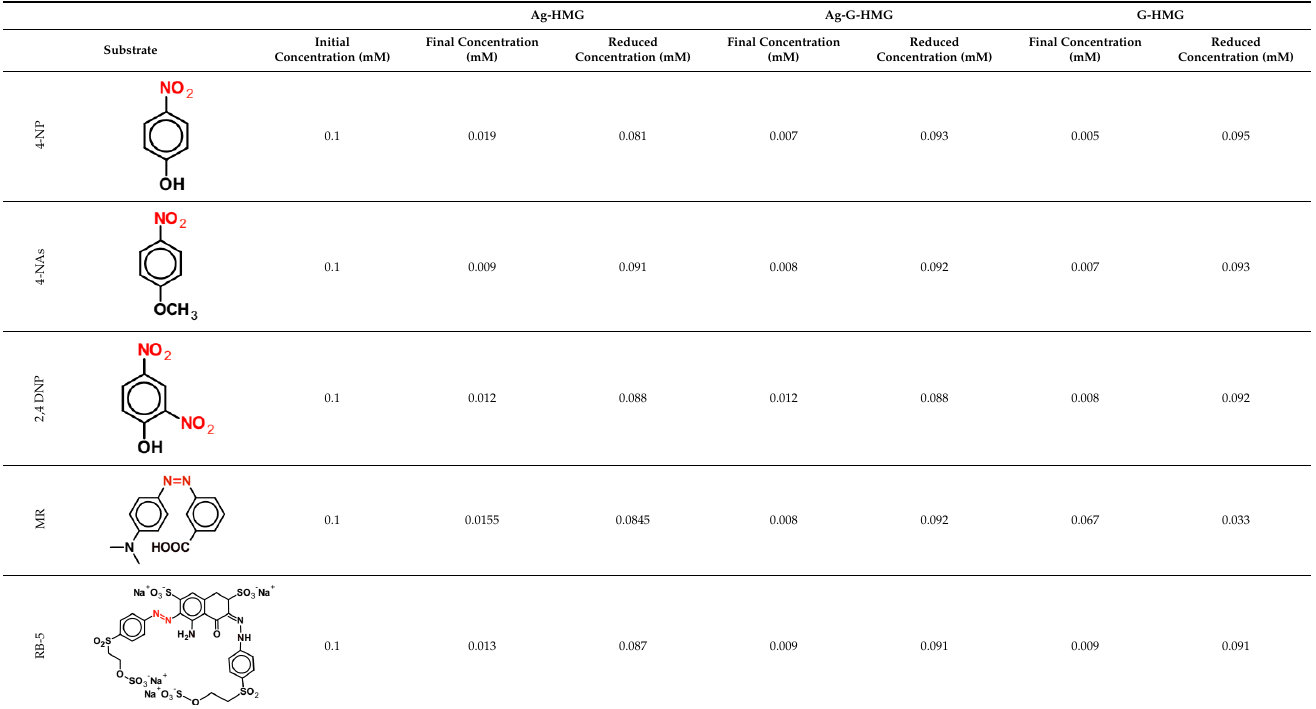
Table 1. Comparison of initial, final, reduced concentrations and reduction time of substrates using 0.1